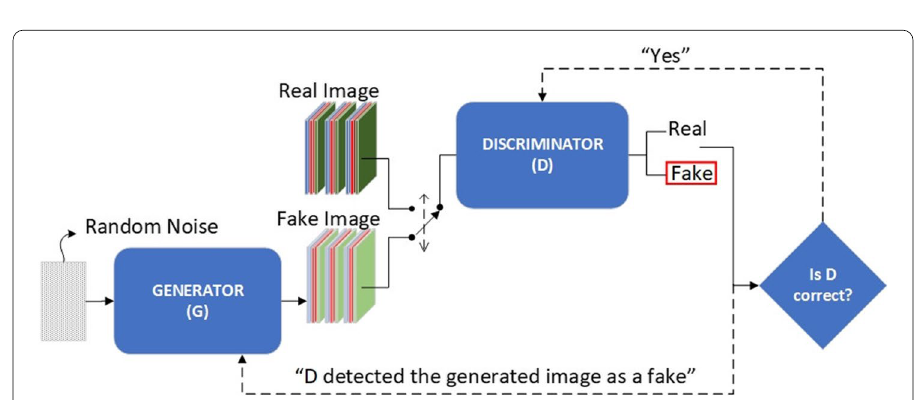
Fig. 5 The architecture of a generative adversarial